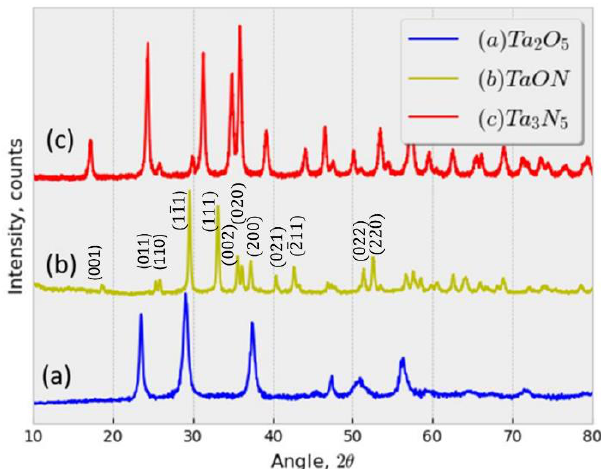
Figure 3. X-Ray diffractograms of the as-synthesized ( a ) Ta 2 O 5 (JCPDS # 00-018-1304), ( b ) TaON (JCPDS # 01-071-0178 40), and ( c ) Ta 3 N 5 (JCPDS # 00-019-1291). # 01-071-0178 40), and ( c ) Ta 3 N 5 (JCPDS # 00-019-1291).